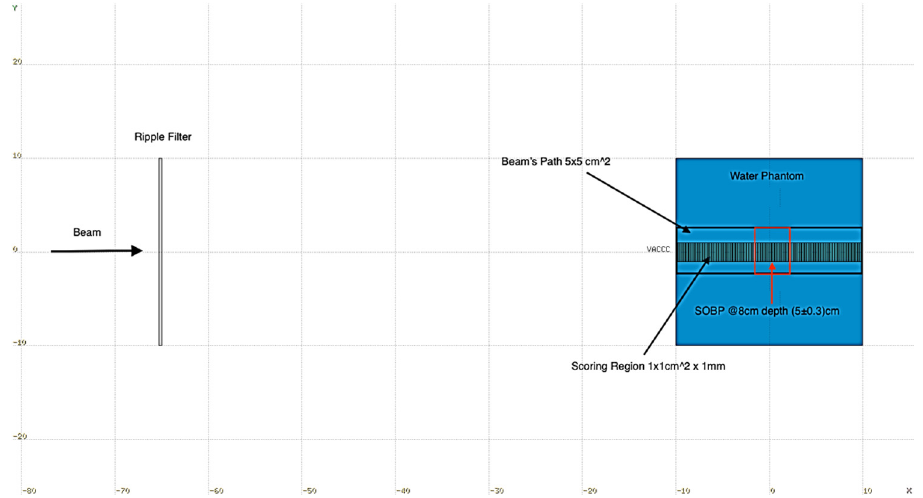
Figure 1. Geometry of the simulations performed throughout this study. The SOBP region is depicted in red. Vacuum (white) is assumed outside the water phantom (blue). Axes are in units of cm.